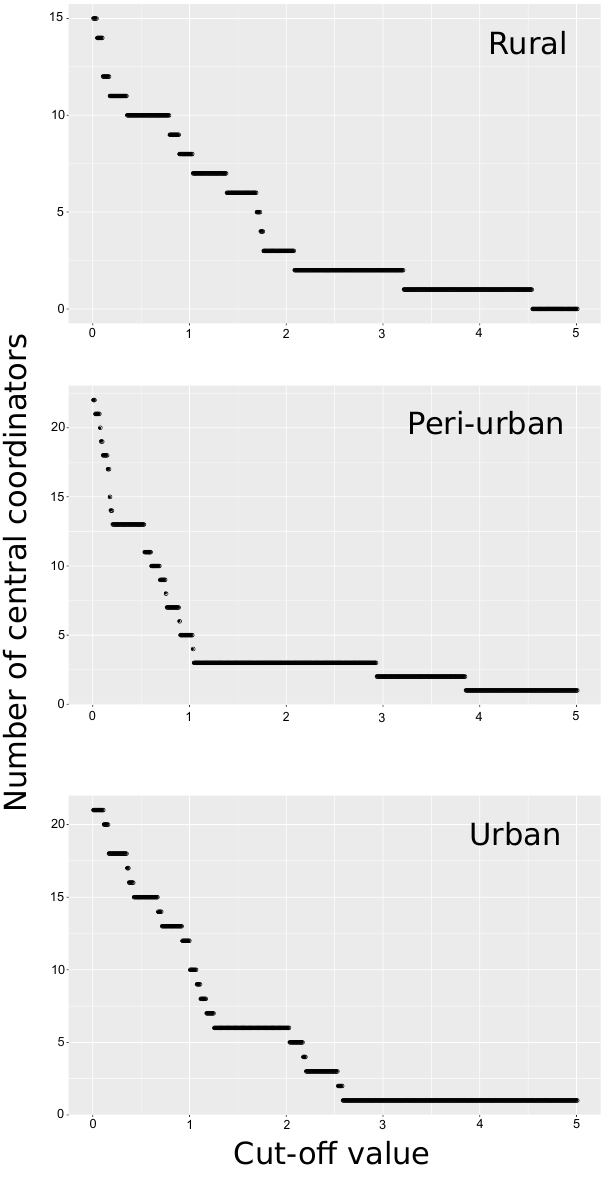
Figure A1 .1 : Sensitivity analyses for number of central coordinators depending on variation in cut-off values (standard deviations above mean ego betweenness score) for rural, peri-urban, and urban